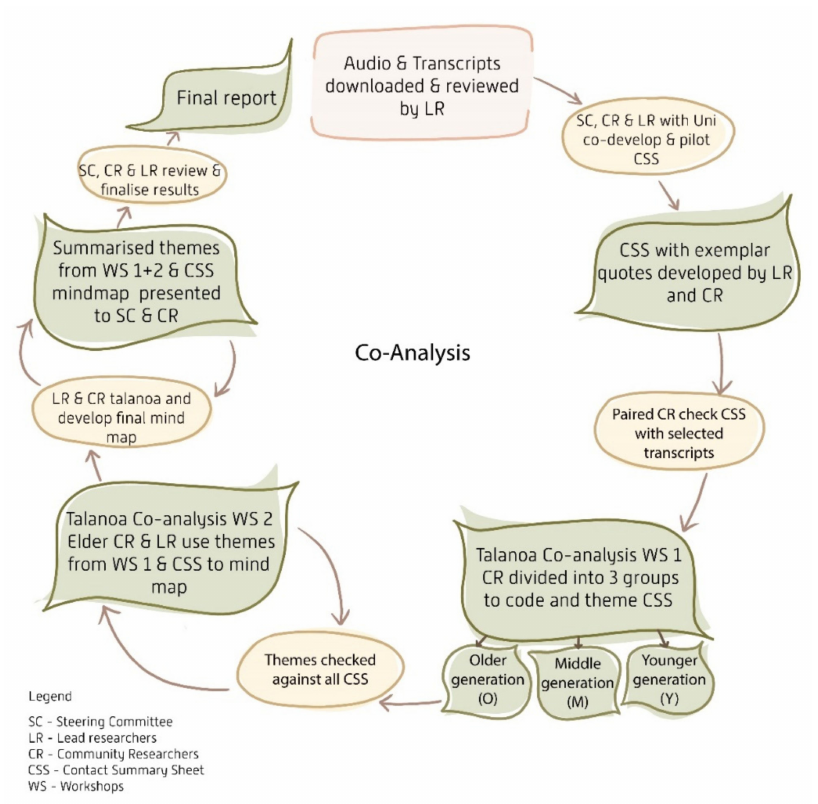
Figure 1. Data analysis